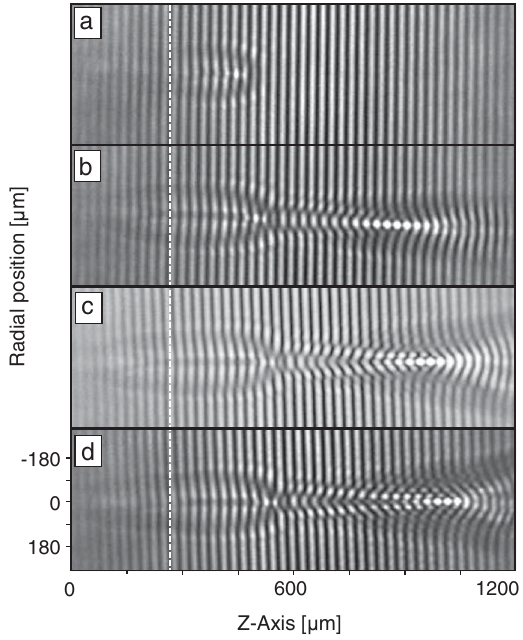
FIG. 4. Interferograms of the plasma channel for the laser power P ¼ 50 GW (the pulse energy of 90 mJ and pulse duration of 1.8 ps) and 1 : 5 (cid:3) 10 19 cm (cid:4) 3 gas density at different times. Parts (a)–(d) show the interferograms at different time delays: (a) 1 ps, (b) 3 ps, (c) 5 ps, (d) 9